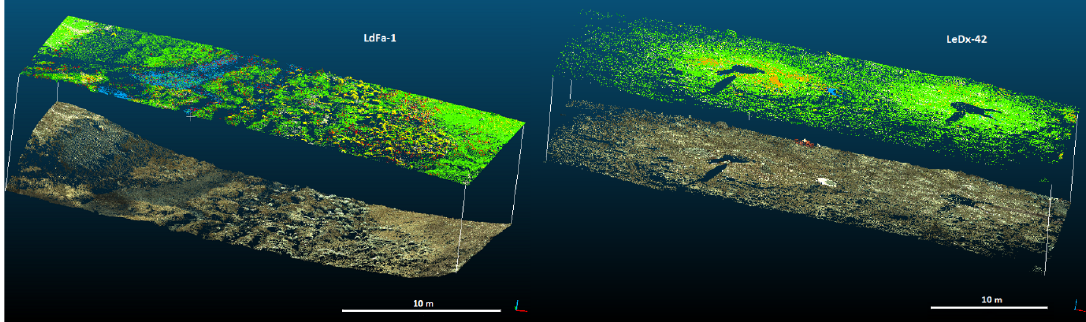
Figure 3: Bottom: Original colour point clouds of LdFa-1 and LeDx-42. Top: Colour classified point clouds using our processing sequence. Colours correspond to the following materials: Blue – Water/Snow; Light Green – Low-vegetation; Dark Green – Medium-vegetation; Red – High-vegetation; Grey – Gravel; Orange – Exposed Outcrop; Yellow – Stone Boulders. Note that the scanner positioning in LeDx-42 caused the shadowed areas in the point clouds.